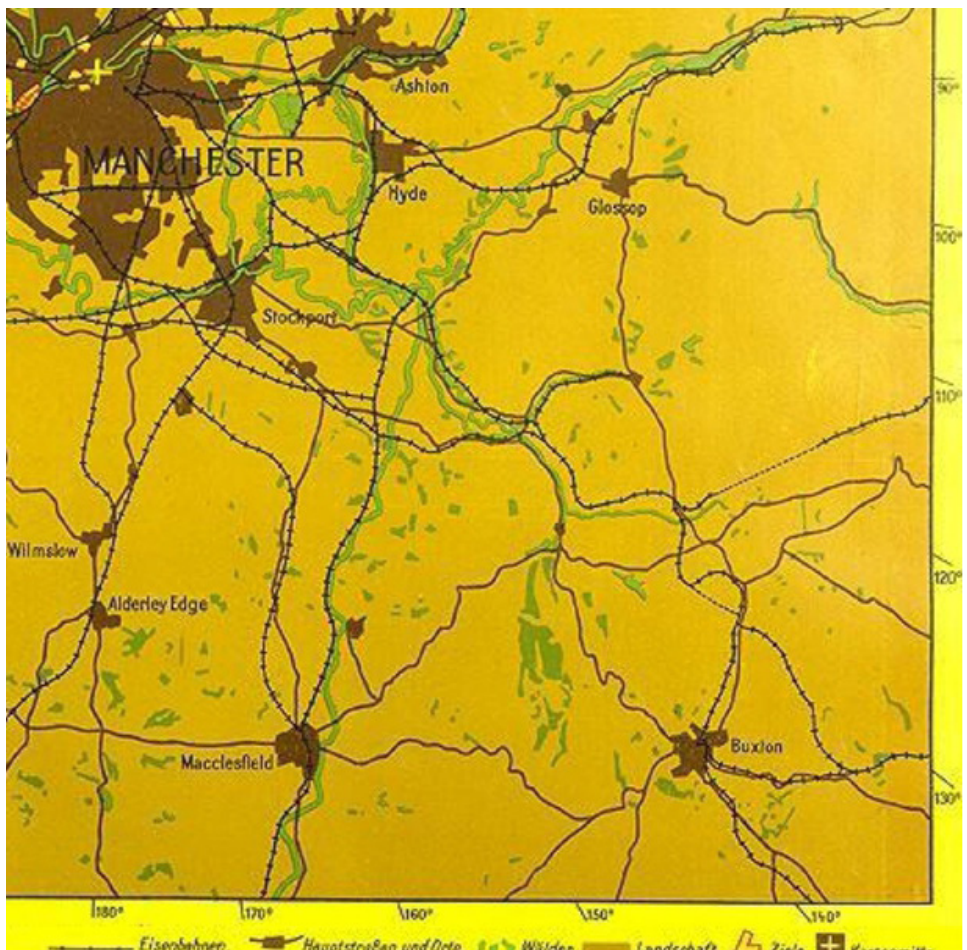
Fig. 9. Part of a German 1:100,000 map (Manchester), published in 1941 and meant to be used for